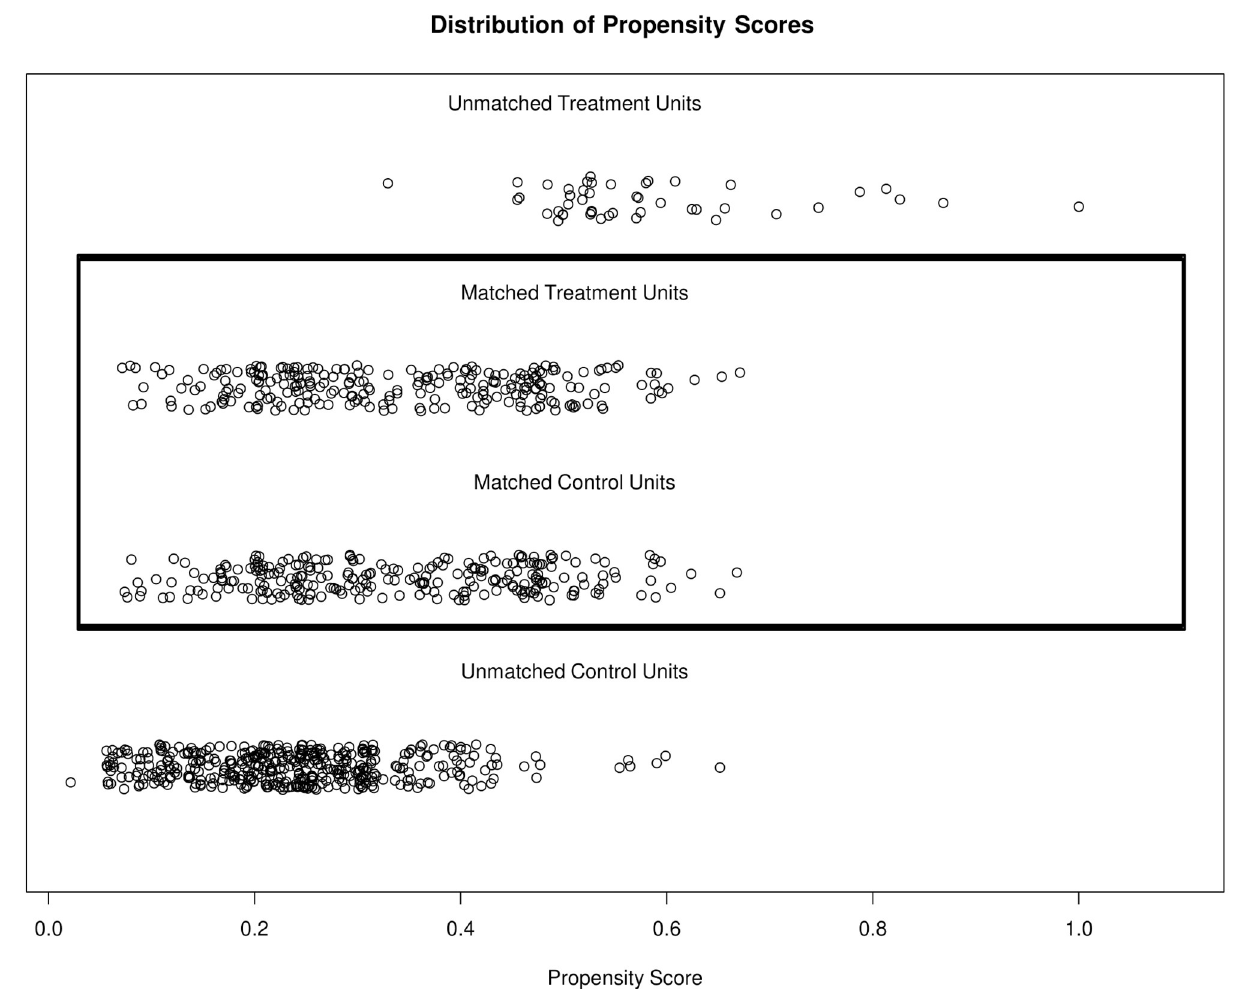
Fig 3. A jitter plot showing the distribution of the propensity scores before and after matching. Raw treated: unmatched disclosed HIV status group; Raw control: Unmatched undisclosed HIV status group; Matched treated: matched disclosed HIV status group; Matched control: matched undisclosed HIV status